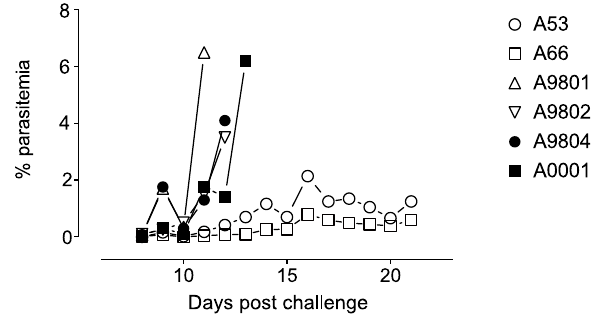
Figure 3. P. falciparum parasitaemia development in all challenged Aotus . Percentage parasitaemia is plotted against day of sampling post challenge. Open symbols, immunized animals; filled symbols, control (naı¨ve, non-immunized) animals.